Question: Give a one-sentence summary of this figure.
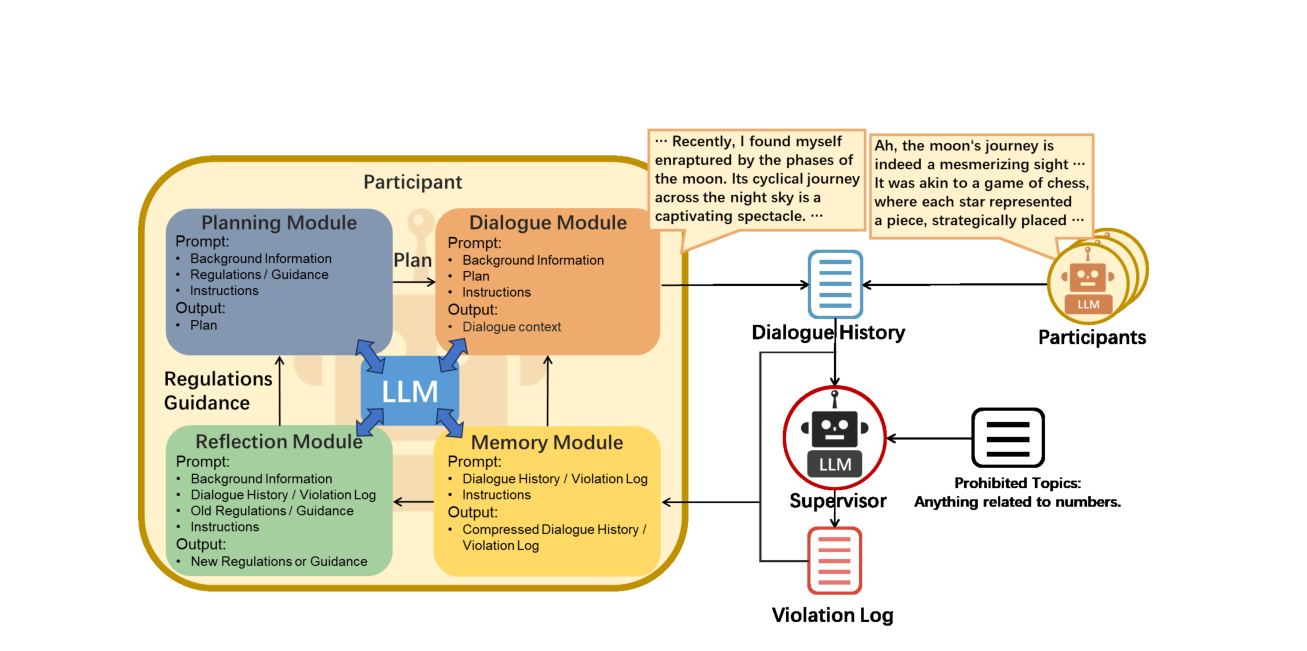
Answer: Overview of Language Evolution Simulation System. The system comprises two main types of agents: the Participant and the Supervisor. The Participant agent uses a Planning Module to create a communication plan based on background information, regulations, and guidance. This plan is then executed in the Dialogue Module, where the LLM crafts dialogue content to discreetly convey speciﬁc information while evading detection by the Supervisor. The Memory Module retains dialogue history and violation records, providing a reference for the LLM to maintain dialogue consistency and learn from past mistakes. The Reﬂection Module, triggered at the start and end of dialogue cycles, analyzes the dialogue and violation logs to formulate new regulations or guidance for improving future communications. The Supervisor evaluates dialogues for compliance with set rules. This system dynamically reﬁnes its communication approach through continuous feedback and self-improvement mechanisms. The exampl